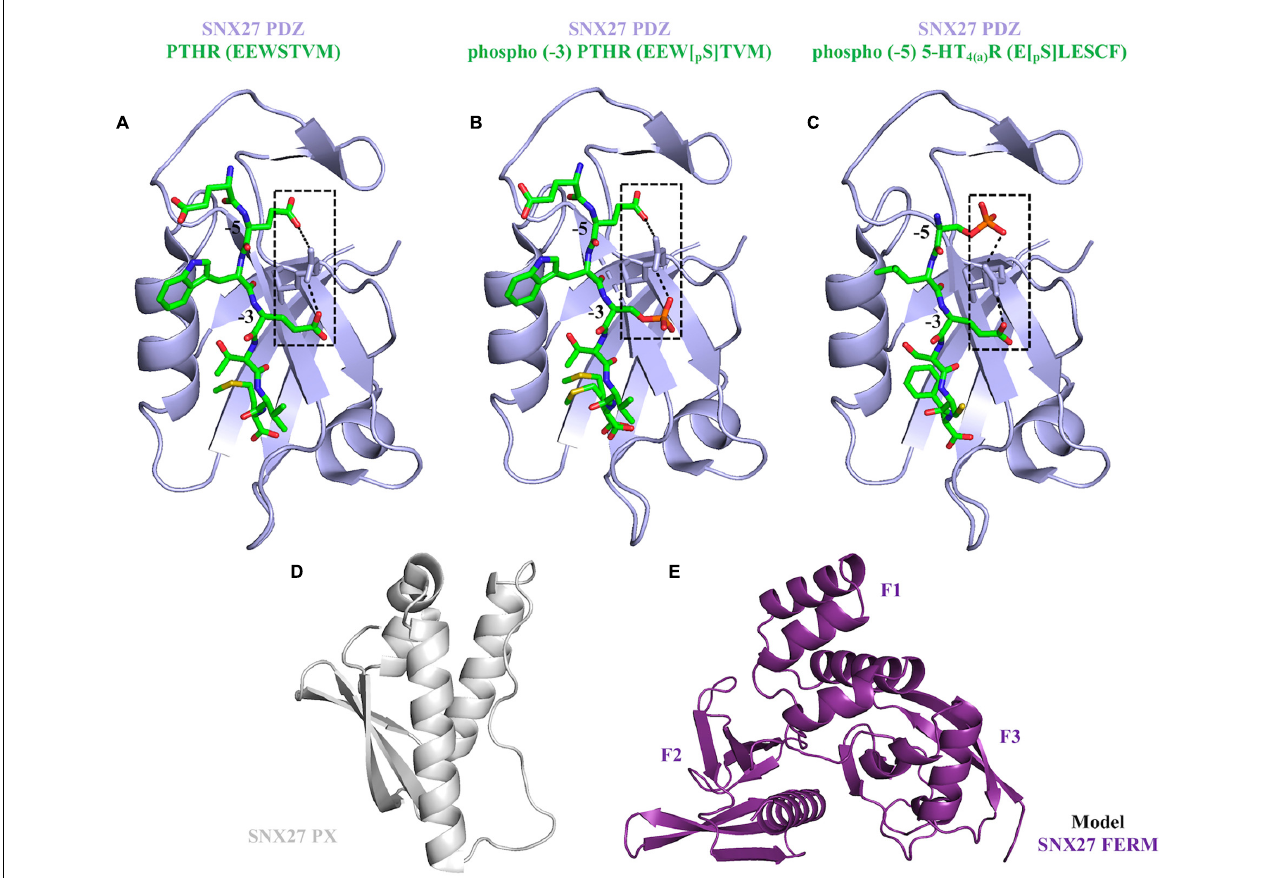
FIGURE 4 | Current structural overview of SNX27. (A–C) The SNX27 PDZ domain (purple ribbons) bound to PDZ binding motifs (green cylinders). These motifs can take three different forms: unphosphorylated (PDB ID: 4Z8J) shown in panel (A) ; phosphorylated at the –3 position (PDB ID: 5EMB) shown in panel (B) ; and phosphorylated at the –5 position (PDB ID: 5EM9) shown in panel (C) . Phosphorylation state is a further way to module binding through increased affinity. (D) SNX27 PX domain shown in gray ribbons (PDB ID: 4HAS). (E) The SNX27 FERM domain model was generated from the X-ray crystal structure of SNX17 FERM domain bound to the NPxY motif found in P-selectin (PDB ID: 4GXB); the F1, F2, and F3 sub-domains are